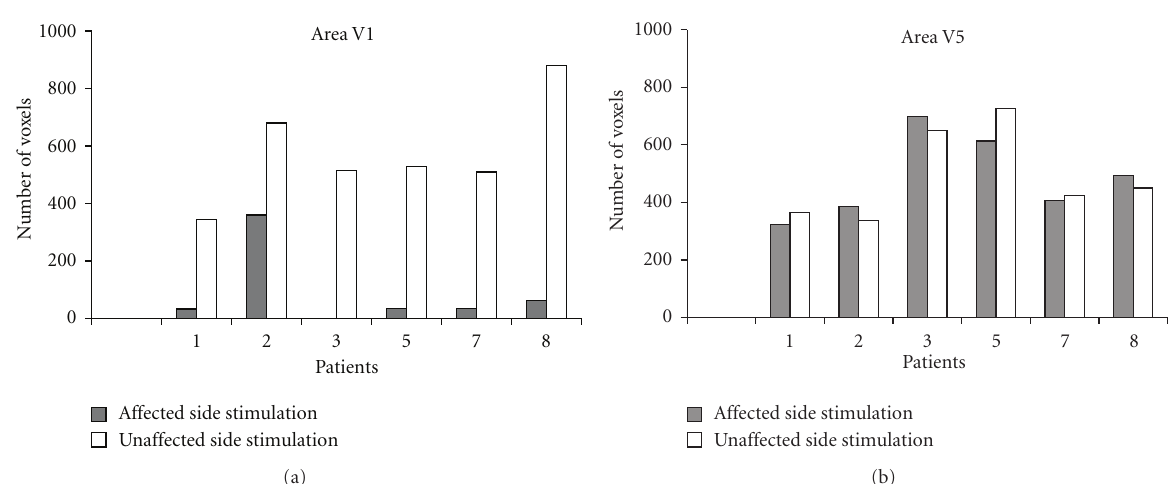
Figure 4: Number of activated voxels in areas V1 (a) and V5 (b) following stimulation of the a ff ected (grey bars) and una ff ected (white bars) eye in 6 patients (data of patients 4 and 6 are not provided due to bad quality of the 3D